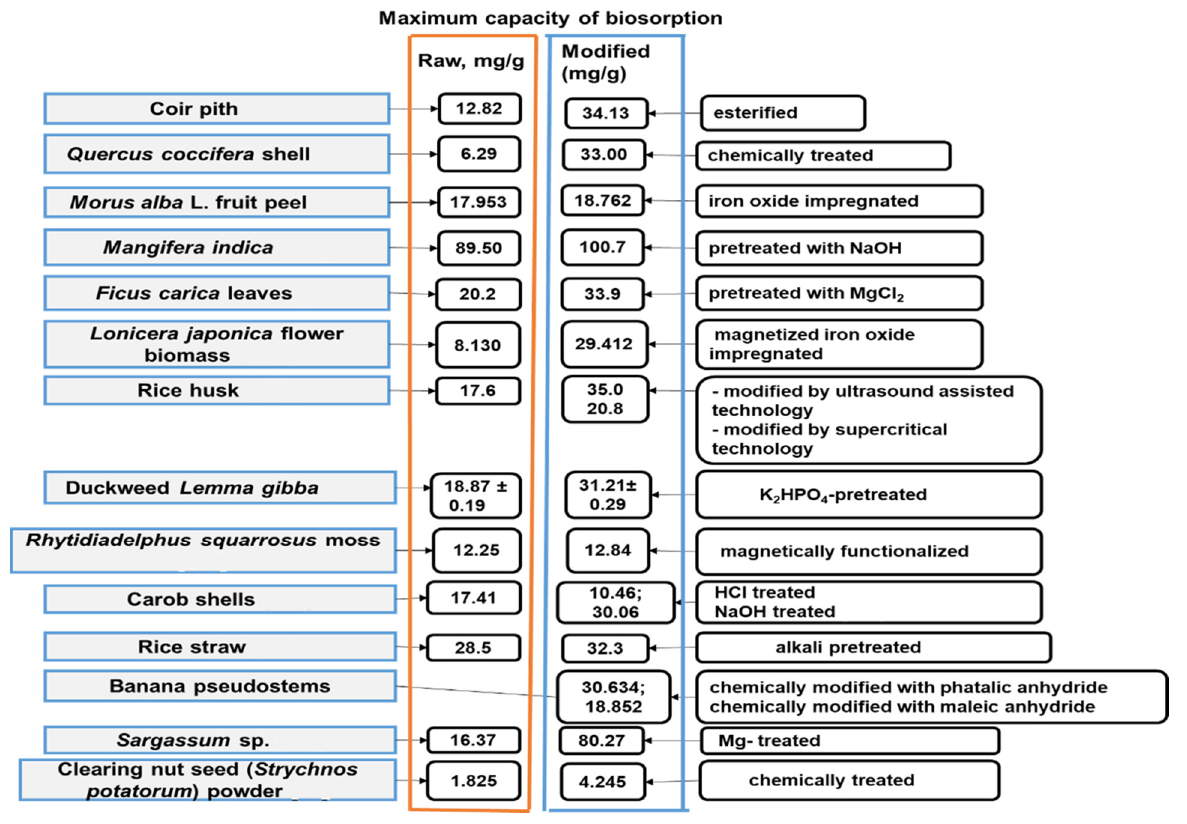
Figure 1. Comparison between raw and modified biomasses for batch removal of Co(II) from synthetic solutions [27,29,94,98–110].